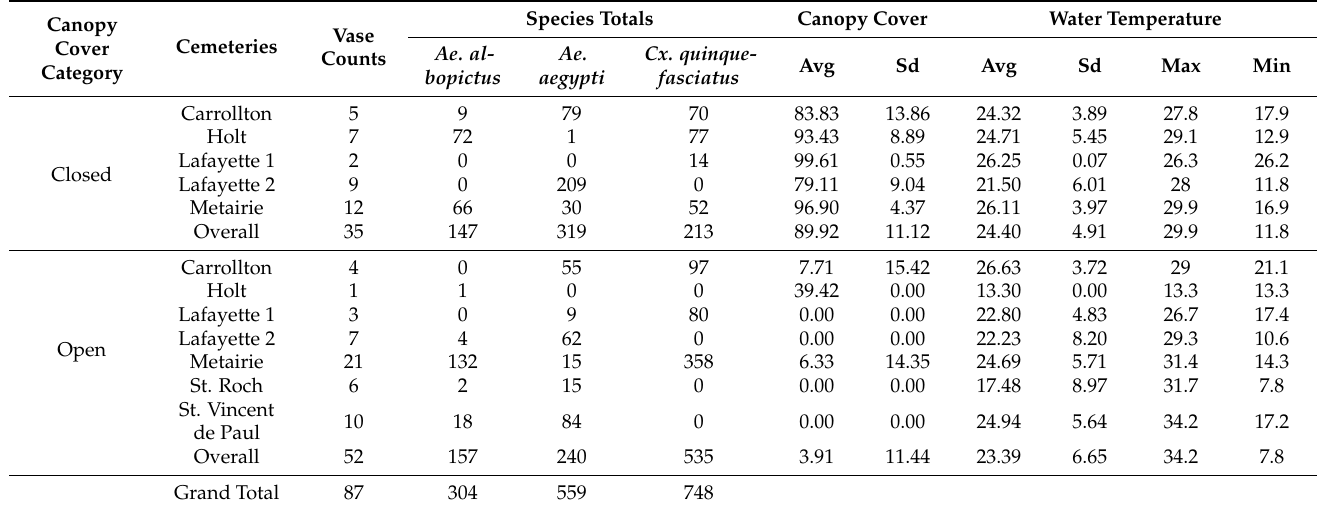
Table 2. Summary statistics describing container traits and species